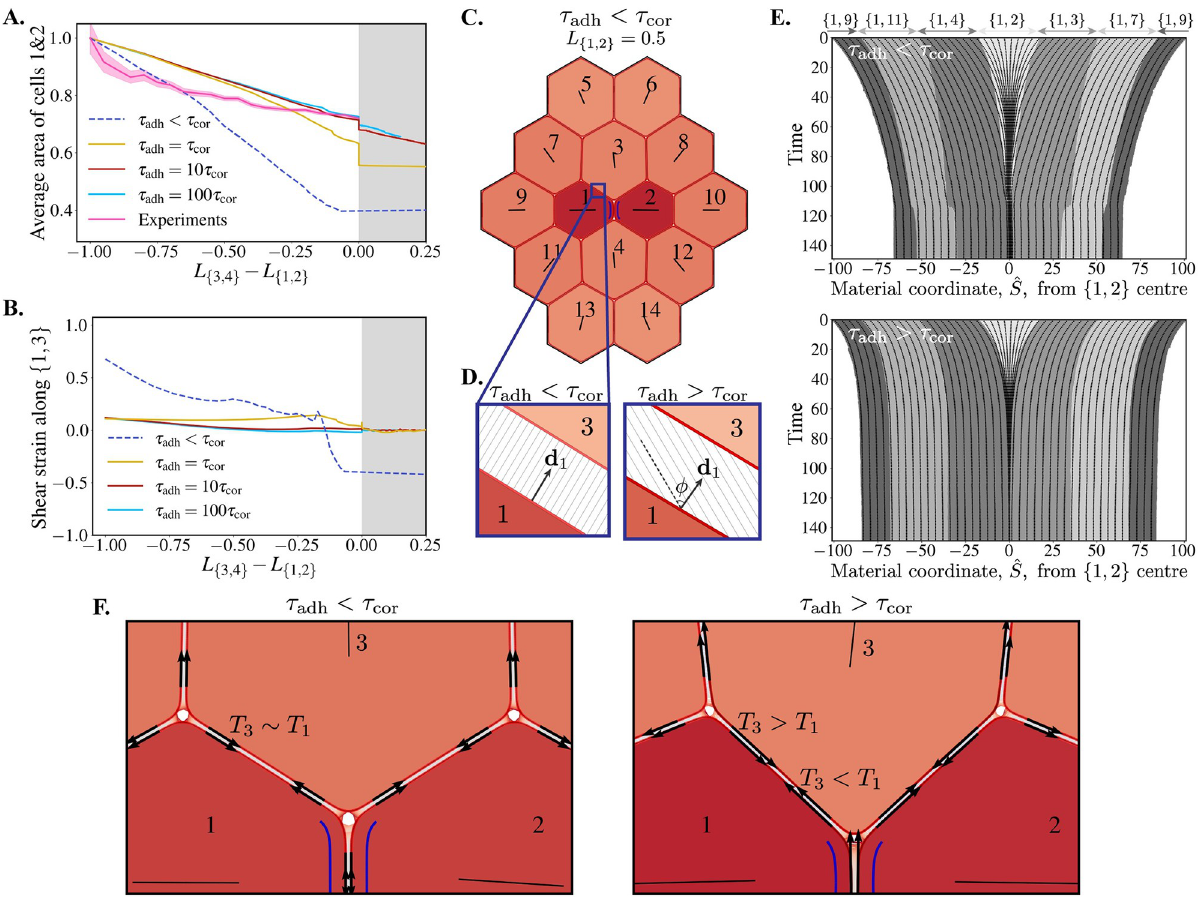
Fig 4. The adhesion timescale regulates area loss, cell–cell slippage, material flow and tension transmission. (A) Average area of cells 1 & 2 vs. signed length of the shrinking/growing T1 junction ( L {3,4} − L {1,2} ) in simulations and experiments, normalised to their initial values. Experimental data are from wild-type cells in the Drosophila germ-band, reanalysed from the dataset originally published in [17]. Shading represents 95% confidence intervals. (B) Tangential shear strain between cortices 1 and 3 at the centre of the {1, 3} junction vs. signed length of T1 junction (as in A ). (C) Snapshot from junction shrinkage simulation with fast adhesions, τ adh < τ cor (see also S4 Movie), where the {1, 2} junction has had a 50% reduction in length, comparable to Fig 3Aii. (D) Example snapshots of adhesions along the {1, 3} junction in fast and slow adhesion turnover conditions. On slow timescales there is a large shear angle, ϕ , relative to the cortex normal, d 1 . (E) Kymographs along the entire cortex of cell 1 during junction shrinkage, for fast (top; S5 Movie) and slow (bottom; S6 Movie) adhesion timescales. Grey shading represents each bicelluar junction, with the {1, 2} junction centred at 0 and eventually disappearing. The x -axis shows the reference material coordinate, S . Fixed material points (black lines; purple dots on cell 1 in Movies 3B and C) are tracked over the course of the simulation. Black lines crossing the grey shading boundaries indicates cortical material passing a vertex and moving between junctions. (F) Zoom of tissues in C (left; see Movies 3D and 3B) and Fig 3Aii (right; see Movies 3E and 3C) showing the different magnitude of tension, T , (black arrows) in the apposed cortices of bicellular